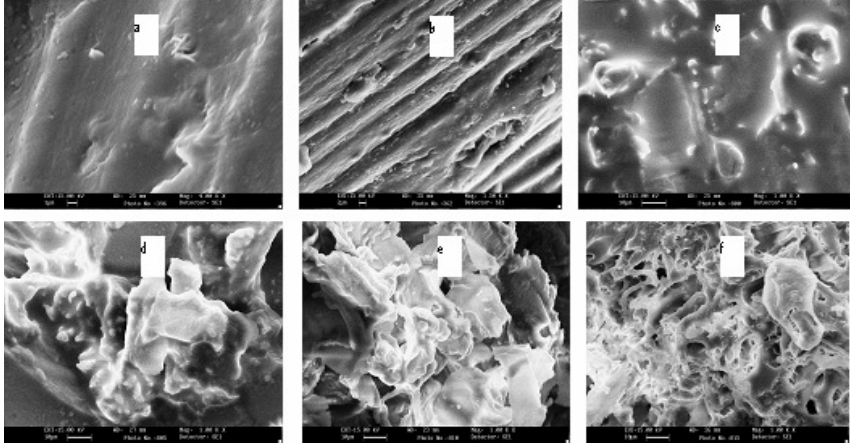
Figure 4. SEM images of (a) RF resin (b) Pine Needles (c, d, e & f) composite with 10, 20, 30 & 40% loadings. Table 4. Thermogravimetric analysis of RF, PN and P-Rnf-RF composites